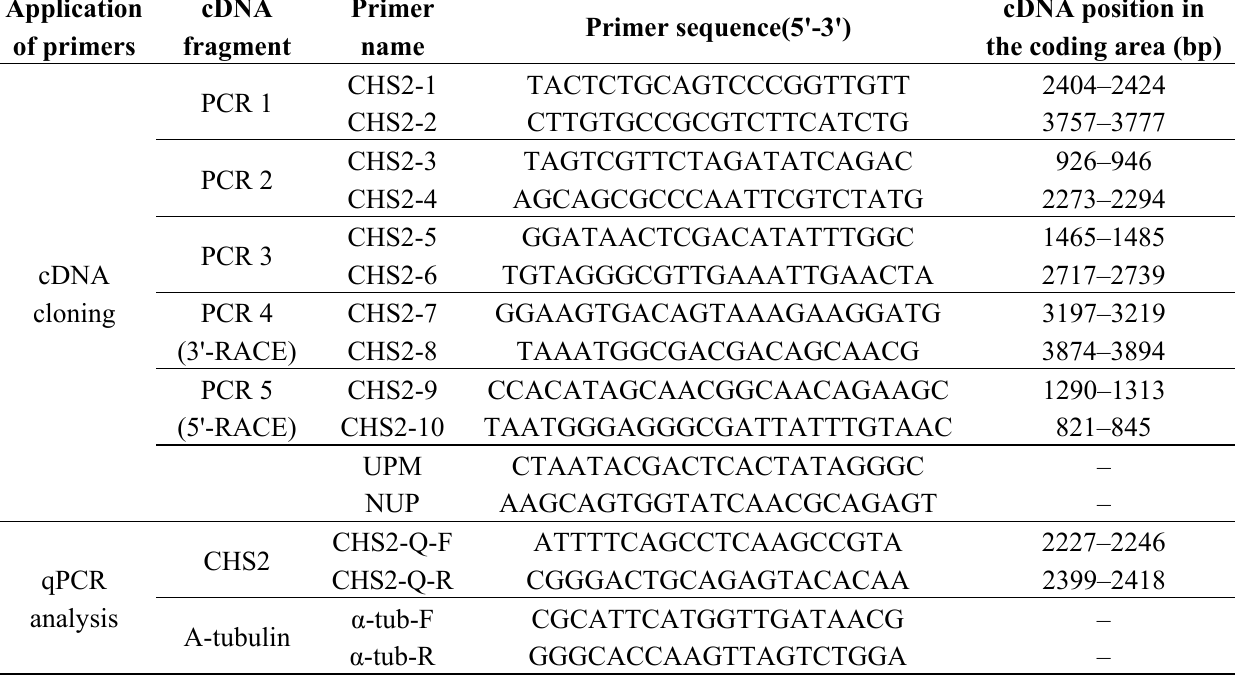
Table 2. Primers used in this